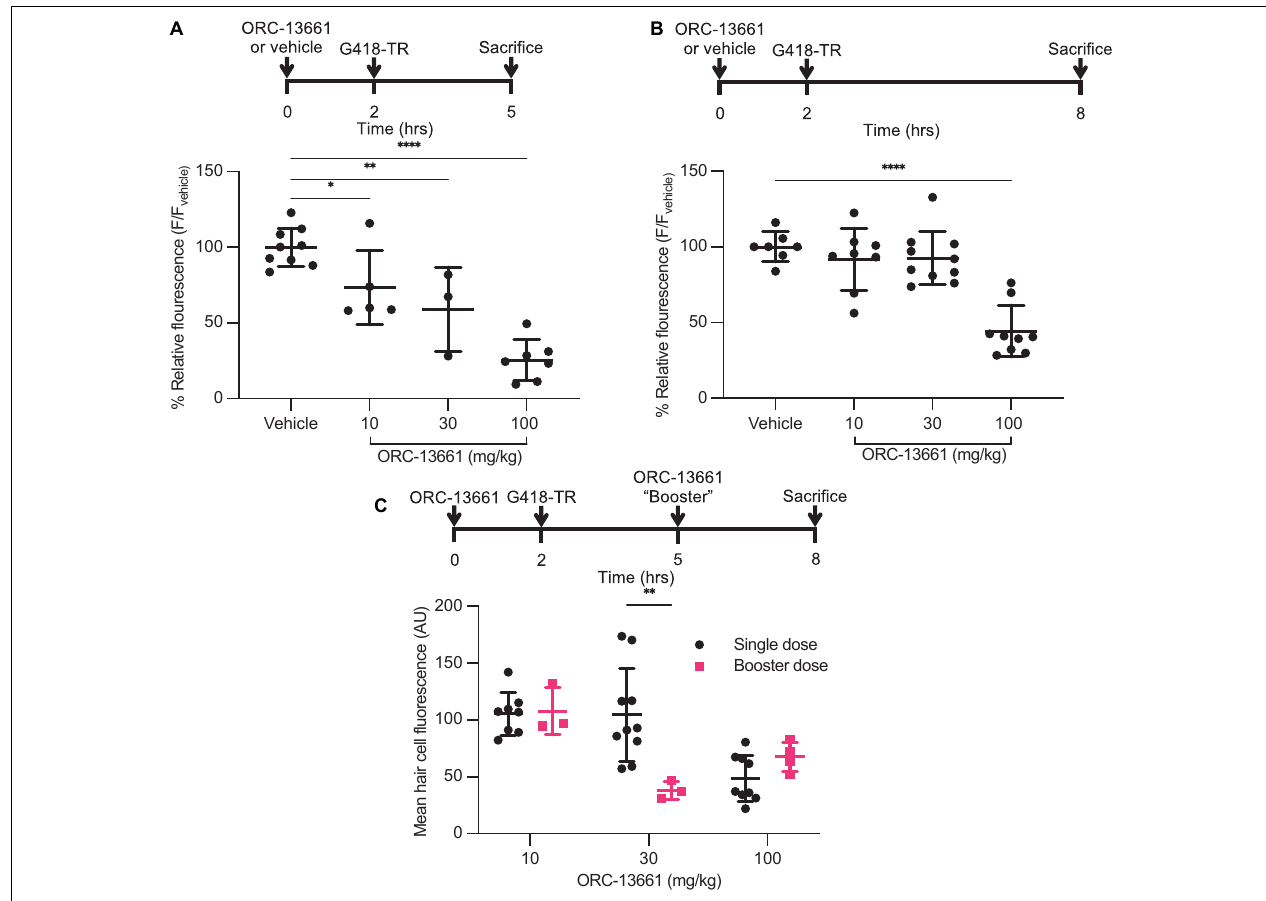
FIGURE 7 | ORC-13661 blocks G418-TR accumulation in mammalian hair cells. (A) Short (3 h) G418-TR exposure paradigm. Neonatal mice were pretreated with ORC-13661 or vehicle for 2 h, injected with 10 mg/kg G418-TR, and sacrificed 3 h after aminoglycoside injection. Basal turn OHC mean fluorescence for animals treated with either vehicle or ORC-13661 followed by 10 mg/kg G418-TR. OHC mean fluorescence was quantified and normalized to animals pre-treated with vehicle within each experimental replicate. [One-way ANOVA; F ( 3 , 20 ) = 23.55, P < 0.0001]. (B) Long (6 h) G418-TR exposure paradigm. Neonatal mice were pretreated with ORC-13661 or vehicle for 2 h, injected with 10 mg/kg G418-TR, and sacrificed 6 h after aminoglycoside injection. [One-way ANOVA; F ( 3 , 30 ) = 19.62, P < 0.0001]. (C) Booster dosing strategy with a single pretreatment injection of ORC-13661 followed by a second booster dose 3 h after G418-TR injection. Basal turn OHC mean fluorescence for animals treated with a pretreatment dose ORC-13661 (10–100 mg/kg) followed by 10 mg/kg G418-TR with an additional booster of ORC-13661 (same as pretreatment dose) 3 h after aminoglycoside administration. Note that data for single dose are non-normalized data from part B . Error bars are standard deviations. ∗ P < 0.05, ∗∗ P < 0.01, ∗∗∗ P < 0.001, ∗∗∗∗ P < 0.0001; P -values generated from multiple comparisons post hoc